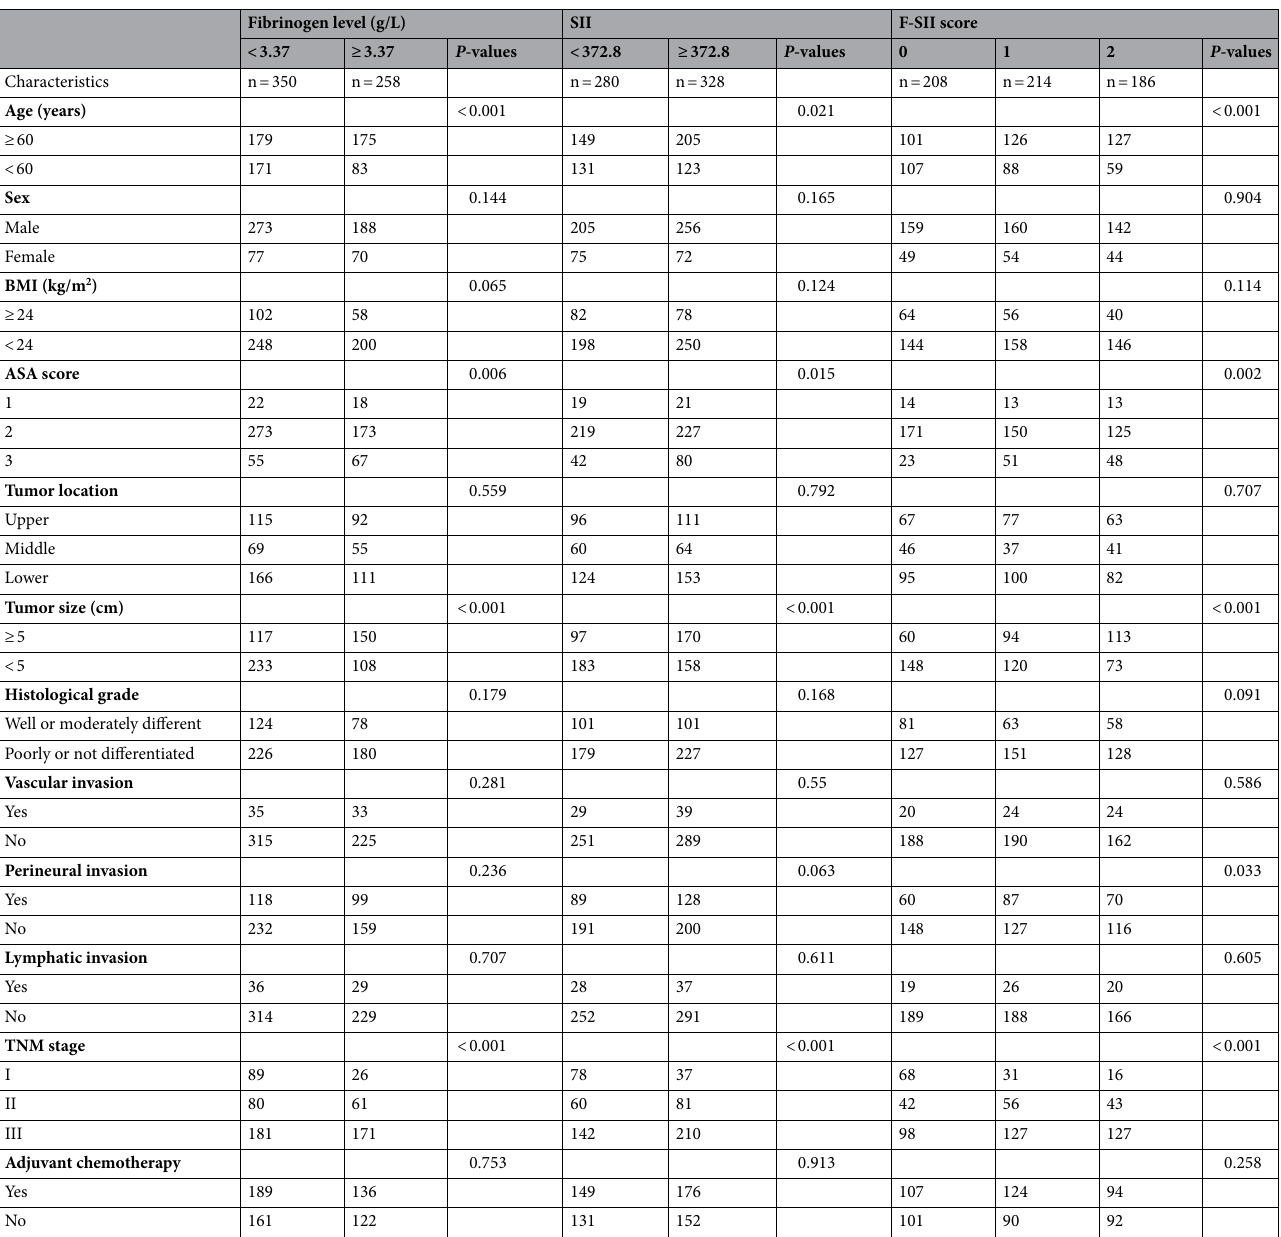
Table 3. Associations of Fibrinogen, SII, and F-SII score with clinicopathological characteristics. BMI Body Mass Index, ASA score American Society of Anesthesiologists score, SII Systemic immune-inflammation index, F-SII Fibrinogen and systemic immune-inflammation